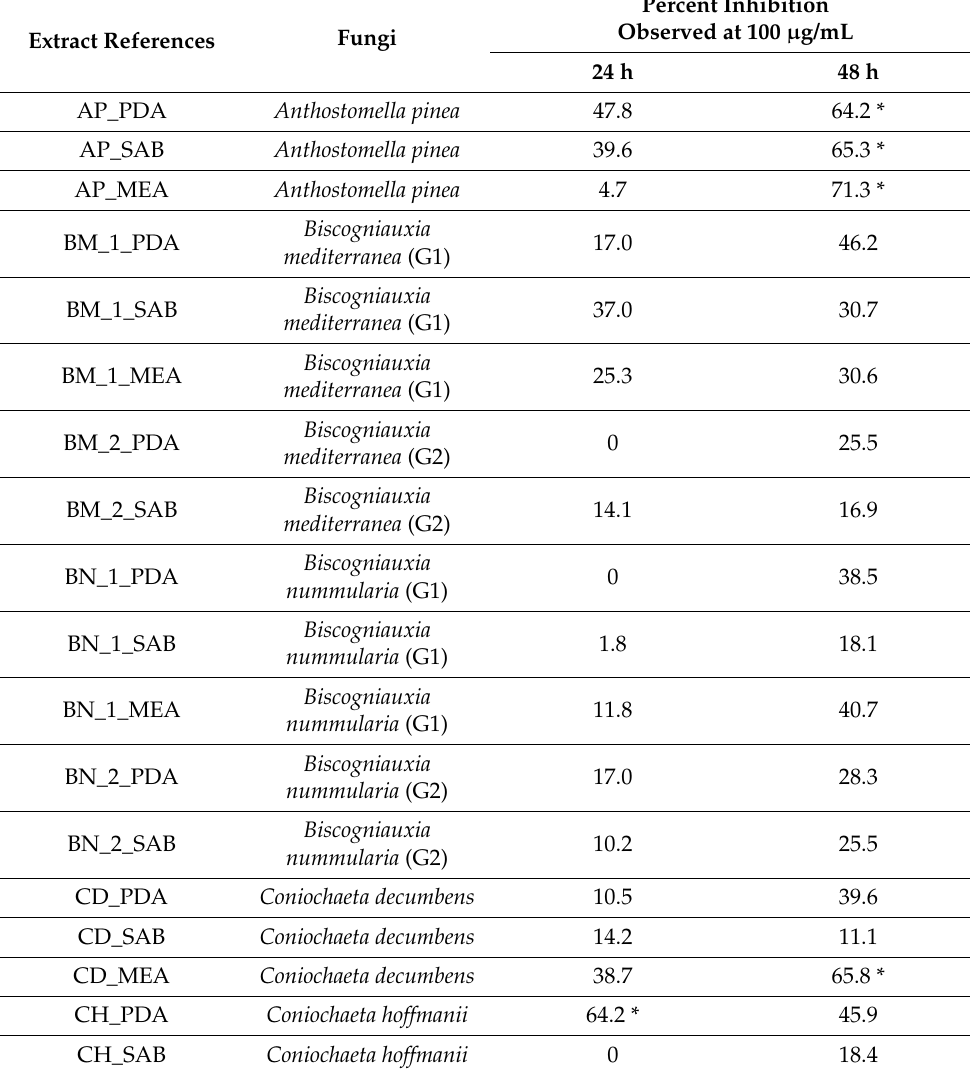
Table 1. Anti-maturation activity of endolichenic fungal extracts at 100 µ g/mL on biofilm of C. albicans ATCC 28367. Extracts were added to yeast after the adhesion phase. The contact duration between biofilm and extracts was 24 h or 48